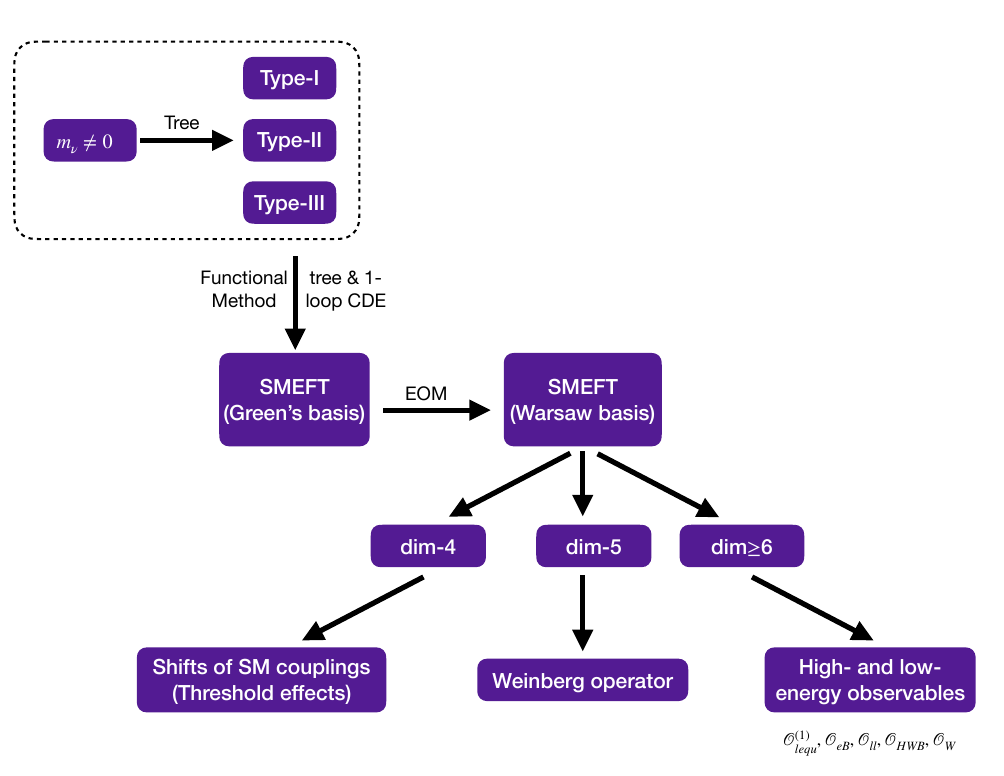
Figure 1 . A schematic plot of the workflow, where the dashed box represent the three UV models that are responsible for neutrino masses at tree level. The operators after the functional matching can be reduced to the Green’s basis, subject to equation of motion redundancy. Eliminating this redundancy results in the Warsaw basis. See the main text for